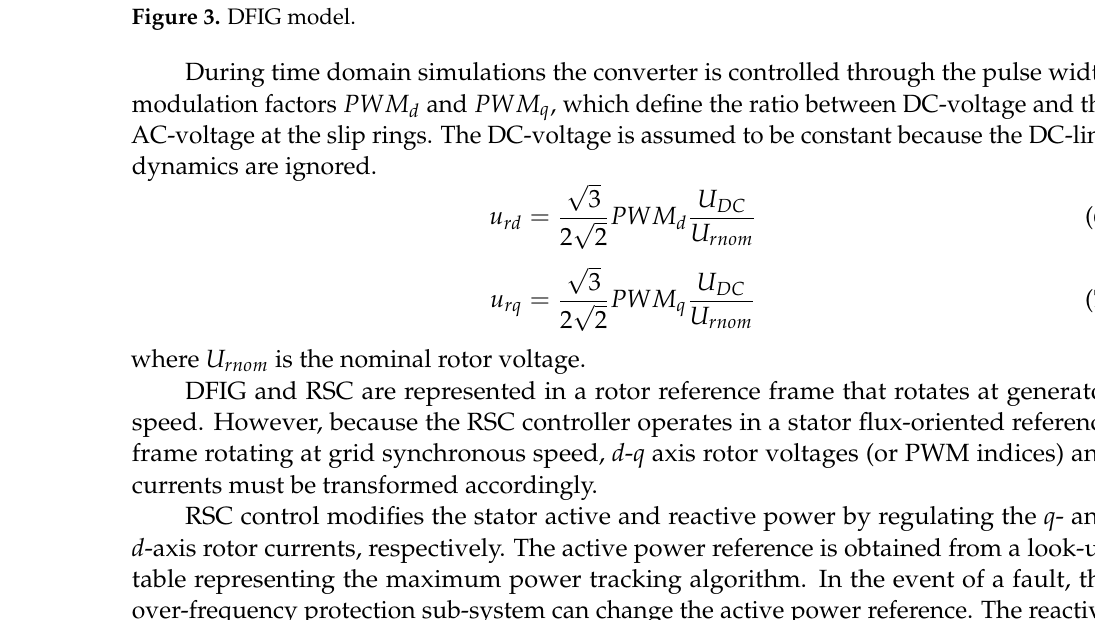
table representing the maximum power tracking algorithm. In the event of a fault, the over-frequency protection sub-system can change the active power reference. The reactive power reference can be obtained from a voltage or power factor